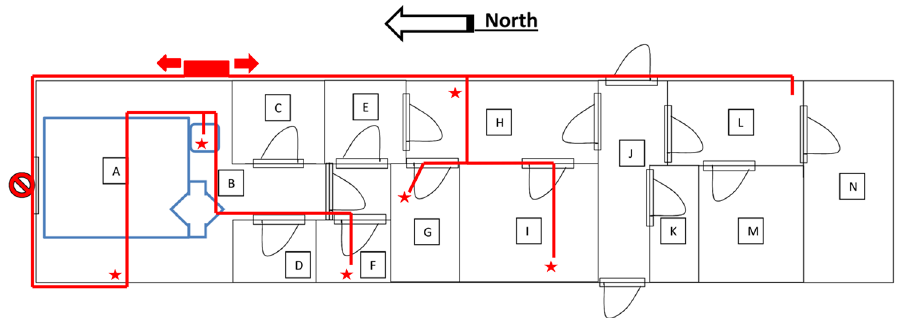
Fig 1. Layout of the SA FEDL in Freetown-Lakka, Sierra Leone with emergencygenerator and wiring to allow for rapid switch to generator mode in case of power failure. ( A ) Biocontainment negative pressurechamber(IsoArk), ( B ) Room housingbiocontainment negativepressure chamber, ( C ) Donning room, ( D ) Doffing room, ( E ) Laboratoryairlock area, ( F ) PCR amplification room, ( G ) PCR master mix room, ( H ) Specimens and reagents storage area, ( I ) RNA extraction room, ( J ) Facility entrance, ( K ) Toilet, ( L ) Office 1, ( M ) Office 2, ( N ) Office 3. Petrol generator(5.5 kVa) placementindicatedby the red rectangle, distribution of extensioncords are indicatedwith red lines, and emergency connectionpoints by red